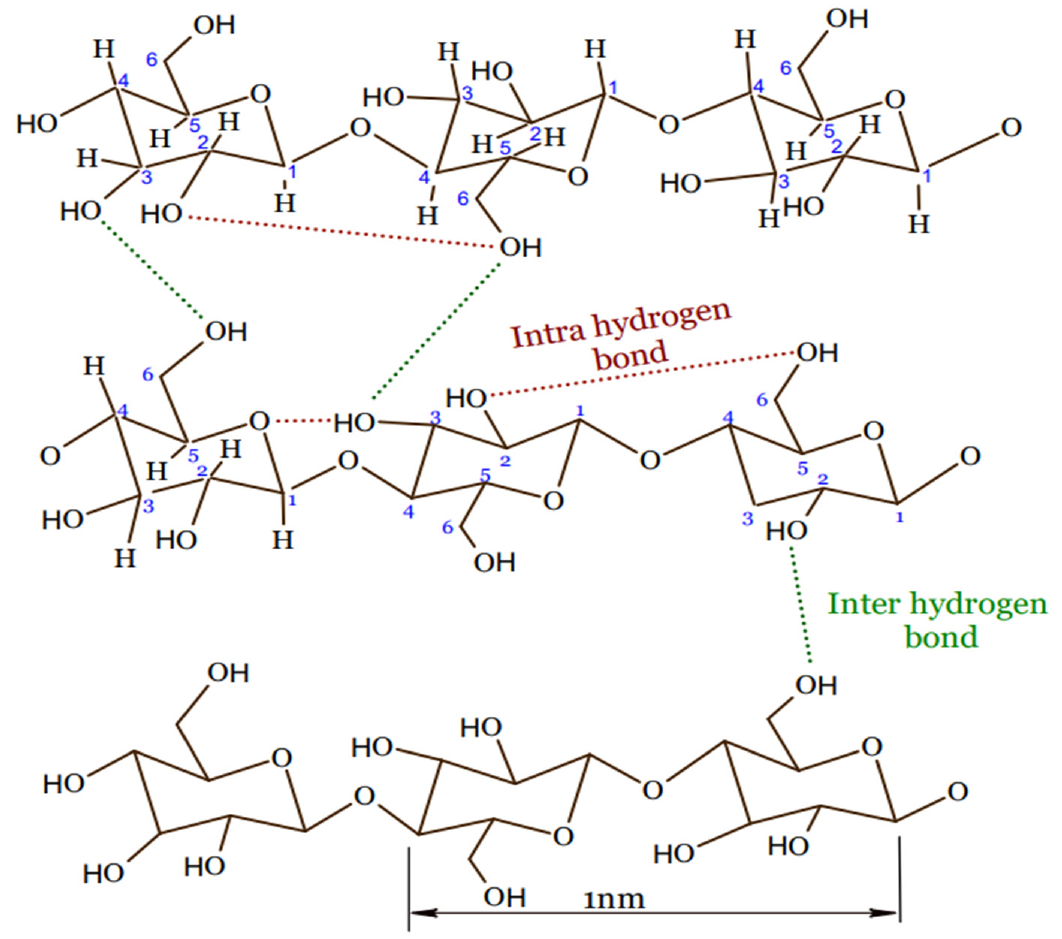
Figure 3. Cellulose structure.